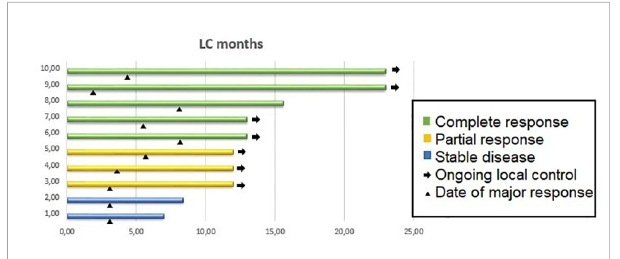
FIGURE 1 Local control duration, response, and date of major